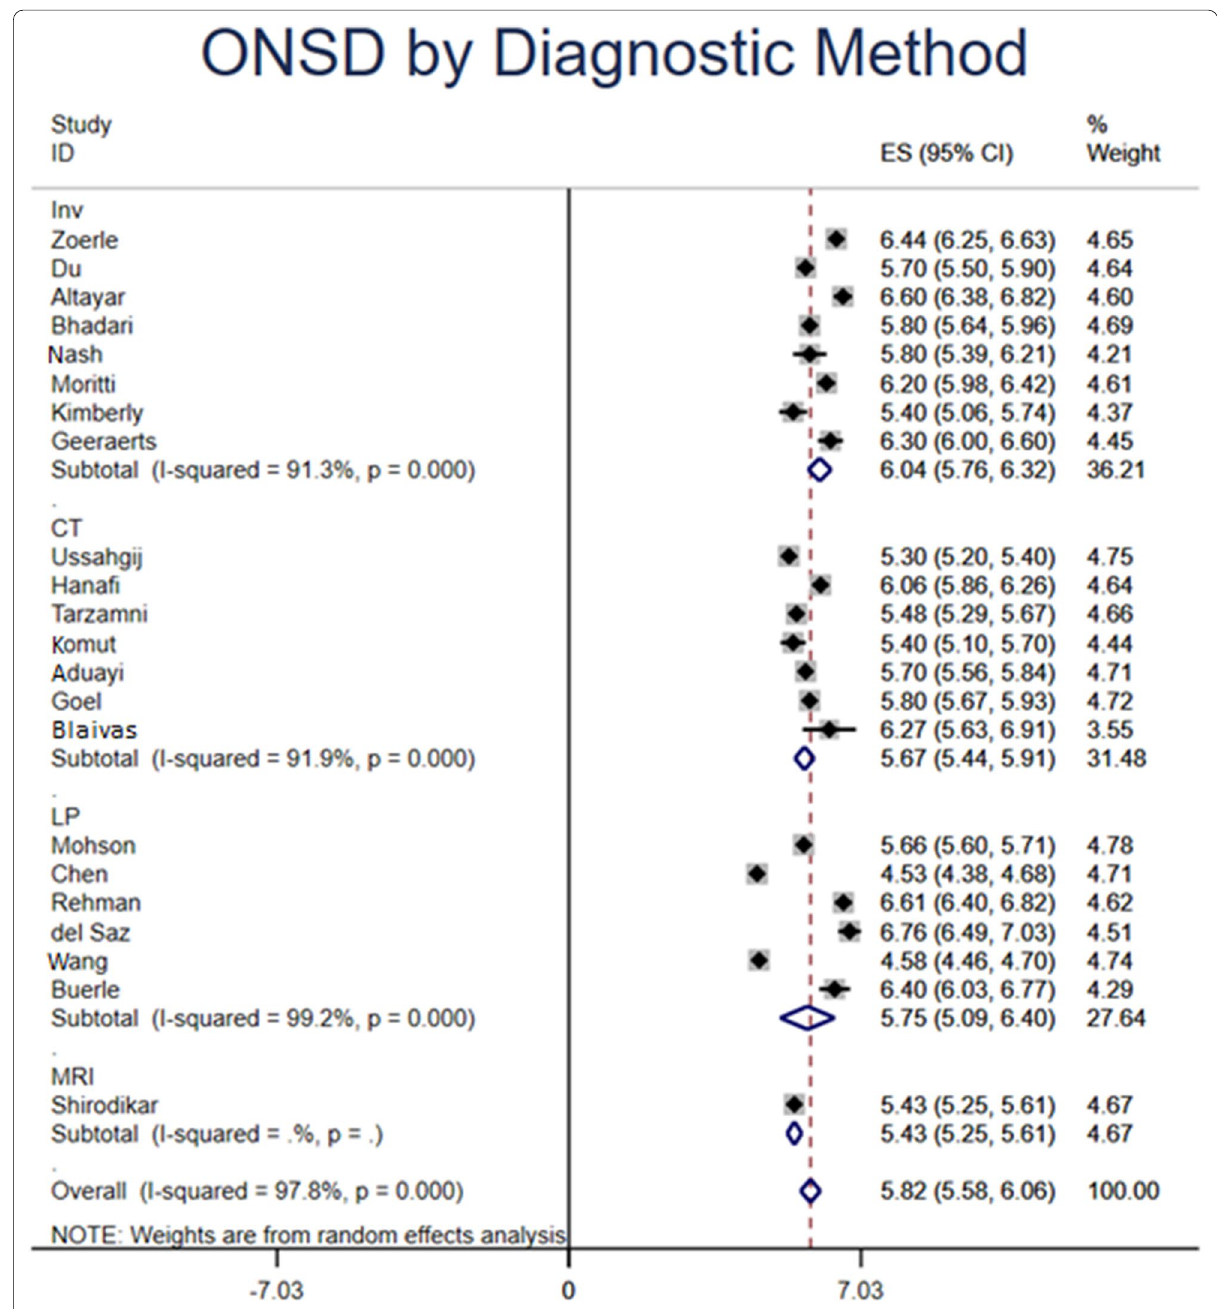
Fig. 4 Optic nerve sheath diameter (ONSD) measured by ultrasound (US) stratified by the diagnostic method of increased intracranial pressure (ICP). MRI magnetic resonance imaging, CT computed tomography, LP lumbar puncture, Inv invasive intracranial